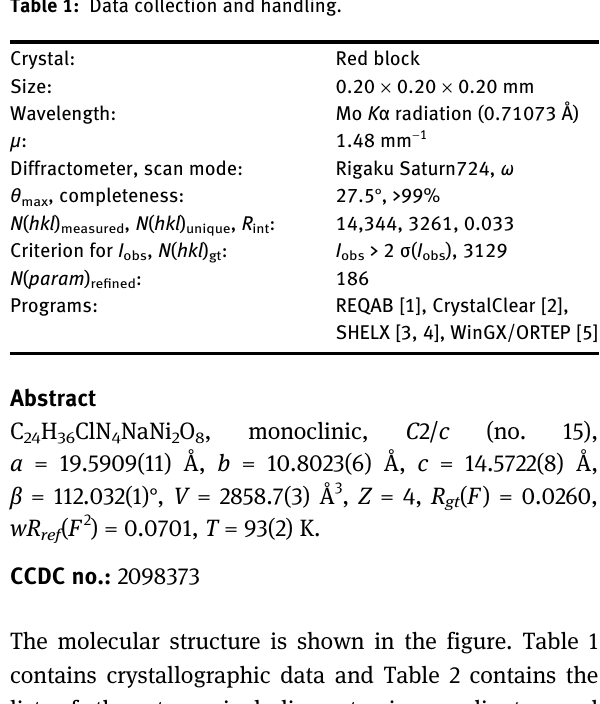
Table  : Data collection and